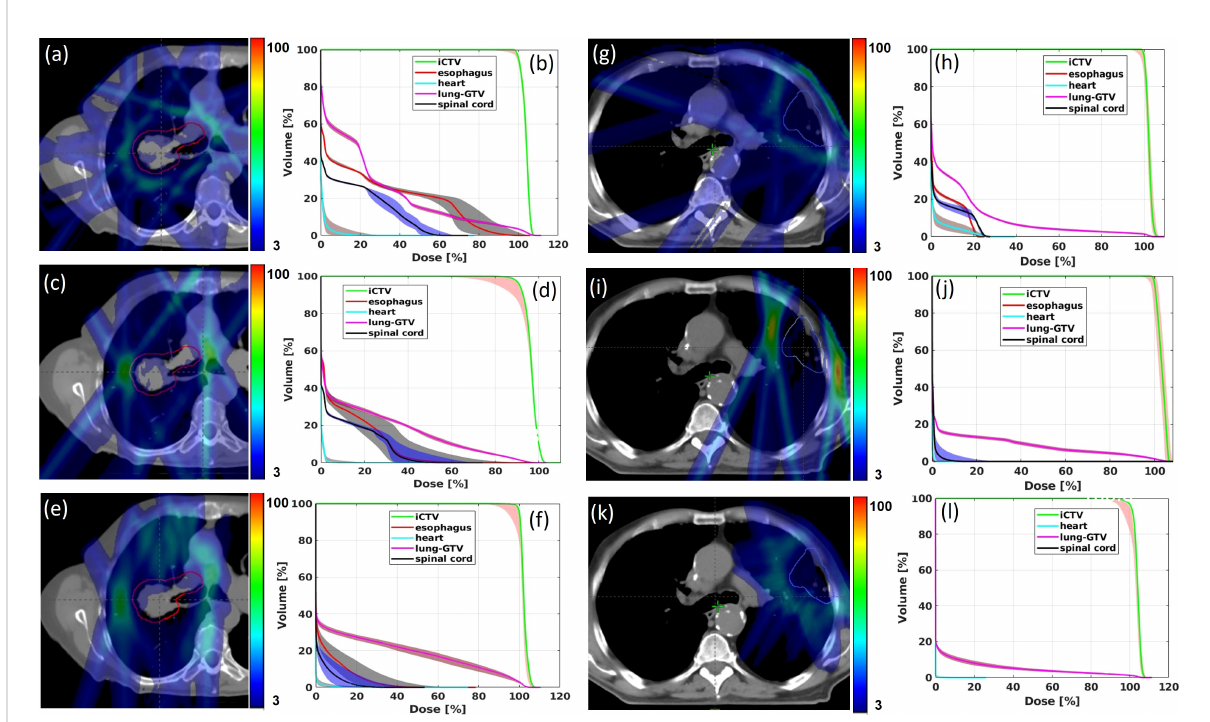
FIGURE 4 Max-min dose distributions from 12 perturbations for Trx-5fds (A, G) , Trx-3fds (C, I) and conventional PBS plans (E) and (K) for patient 1 and 2. DVH bands from 12 perturbations for Trx-5fds (B, H) , Trx-3fds (D, J) and conventional IMPT plans (F, L) .